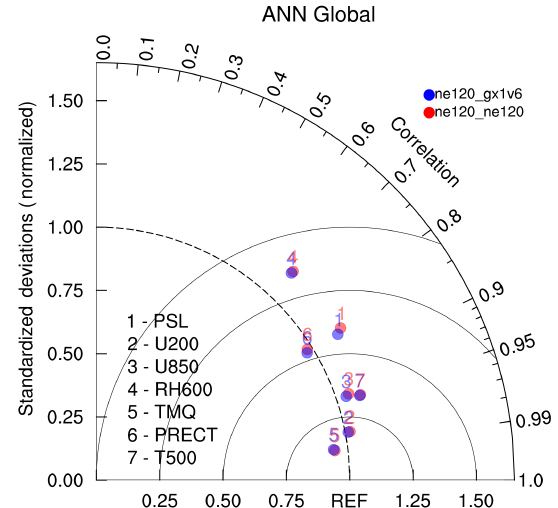
Figure 2. Taylor diagram for globally and annually averaged cli- mate statistics. Blue circles represent the results from AMIP simu- lation coupled to 1 ◦ ocean grid (ne120_gx1v6) and red circles repre- sent the same for simulation using 0.25 ◦ ocean grid (ne120_ne120). See text for description of the diagram and explanation of abbrevi-